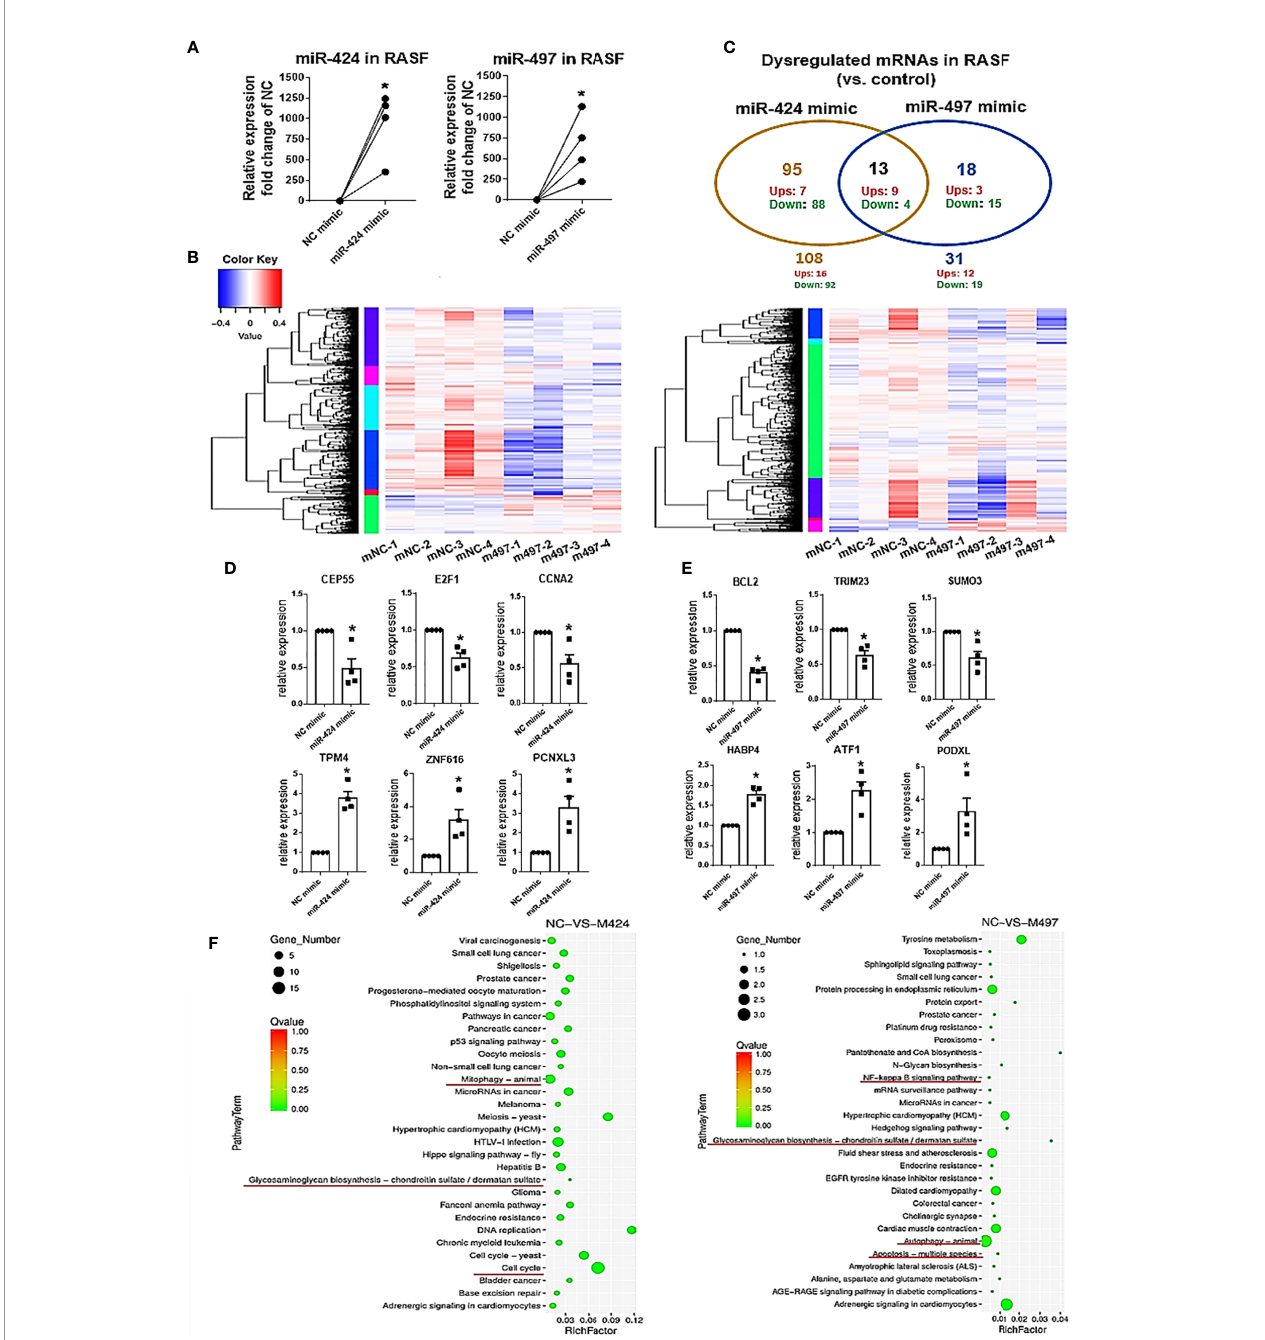
FIGURE 2 | MRNA deep sequencing results and validation after gain of miR-424 and miR-497 function for 48 h in RASF. (A) The expression of miR-424 and miR- 497 in RASF transfected with 10 nM mimic 48h detected by using RT-qPCR. (B) Heat map of all dysregulated genes from mRNA deep sequencing from 10nM miR- 424 or miR-497 mimic-treated RASF cells. (C) Venn diagram of dysregulated genes in miR-424 and miR-497 mimic-treated cell from miRNA deep sequencing results. (D, E) RT-qPCR results of dysregulated genes in miR-424 mimic-treated cells (D) and miR-497 mimic-treated cells (E) . (F) KEGG signal pathway analysis diagram. RASF cells isolated from synovial tissue of 4 RA patients were transfected with miR-424 or miR-497 mimics and inhibitors, respectively. Triplicates were used for each transfection experiment. Bar: mean ± SEM of samples from 4 patients. P <0.05, *: vs. NC mimic, using Mann-Whitney U